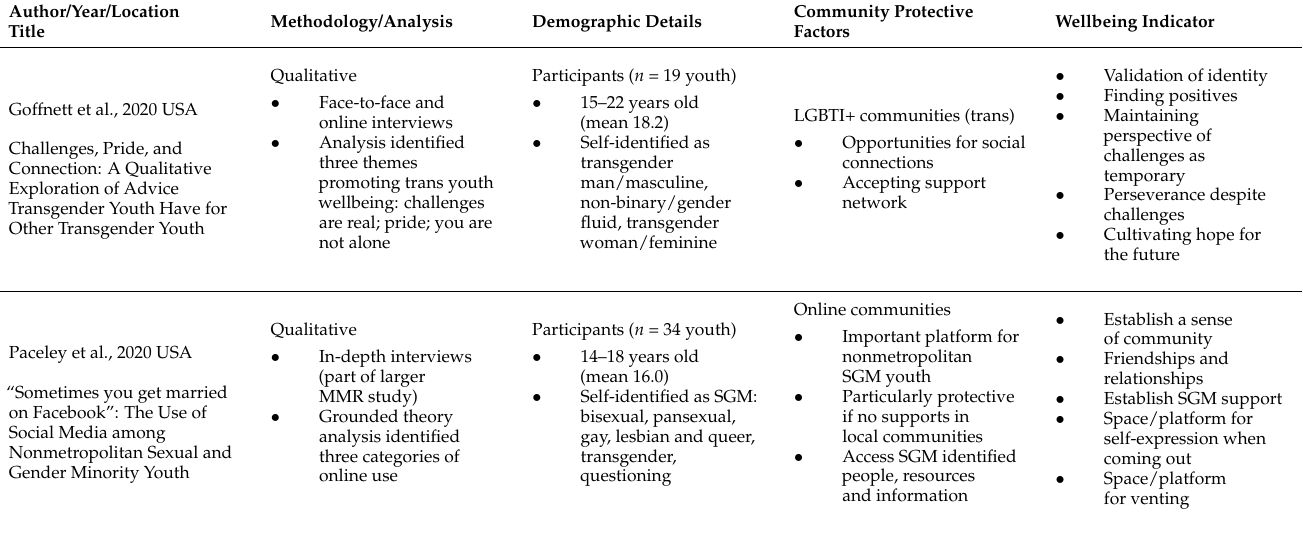
Table 5. Qualitative records of community protective factors for LGBTI+ youth wellbeing: LGBTI+, online, faith and cultural communities ( n =